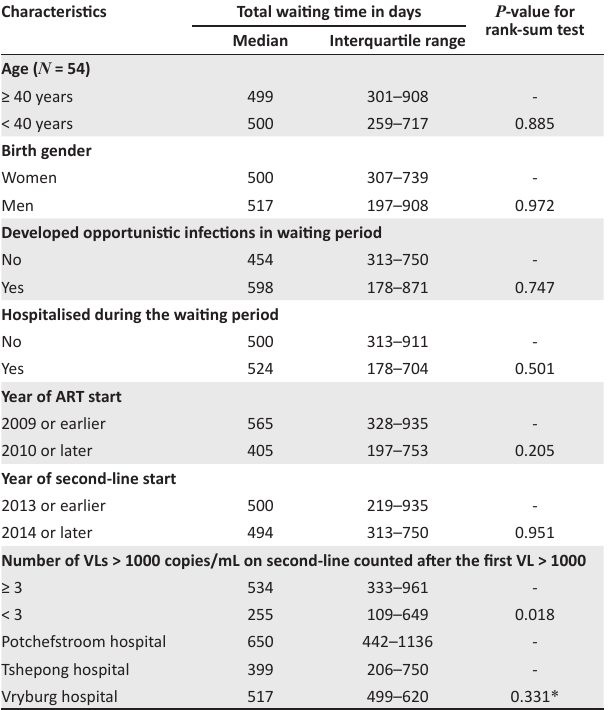
TABLE 2: Analyses of variables associated with first viral load > 1000 copies/mL to the Committee application being submitted.